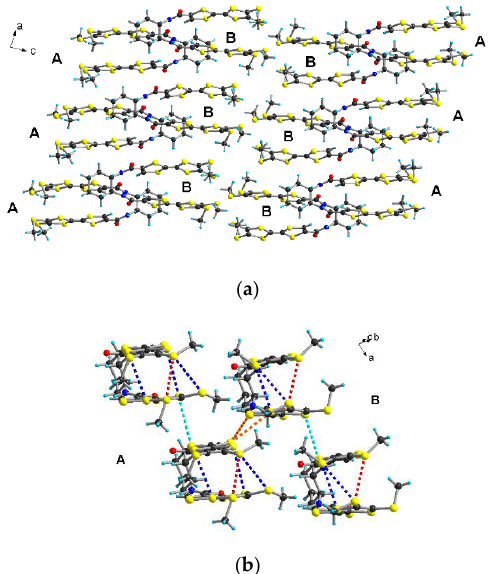
Figure 6. Packing of ( rac )- 1 ( a ) in the ac plane and the intra- and intermolecular S···S short contacts ( b ). Both the A - and B -type molecules interact laterally with each other by a hydrogen bonding N–H ··· O type of 2.24–2.25 Å (magenta dotted lines) and C–H ··· O type of 2.28–2.48 Å (green dotted lines). Moreover, the dimers of the AA and BB molecules further interact in a tail-to-tail fashion through the S ··· S short contacts of 3.46–3.58 Å (red dotted lines) (Figure 7).